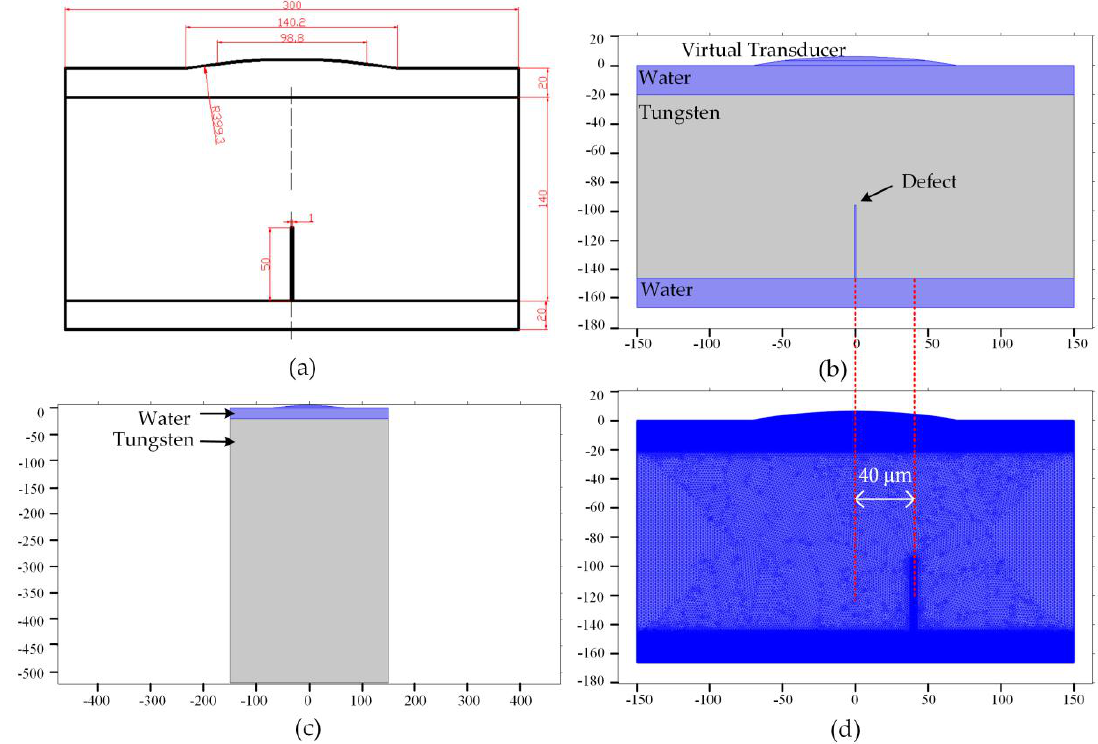
Figure 1. The simulation model (unit in μm ): ( a ) The geometrical model; ( b ) Area segments in the model with defect; ( c ) Area segments in the model without defect; ( d ) Meshing with 10 elements per wavelength, and the position of defect is offset to emulate the transducer scanning in AMI.